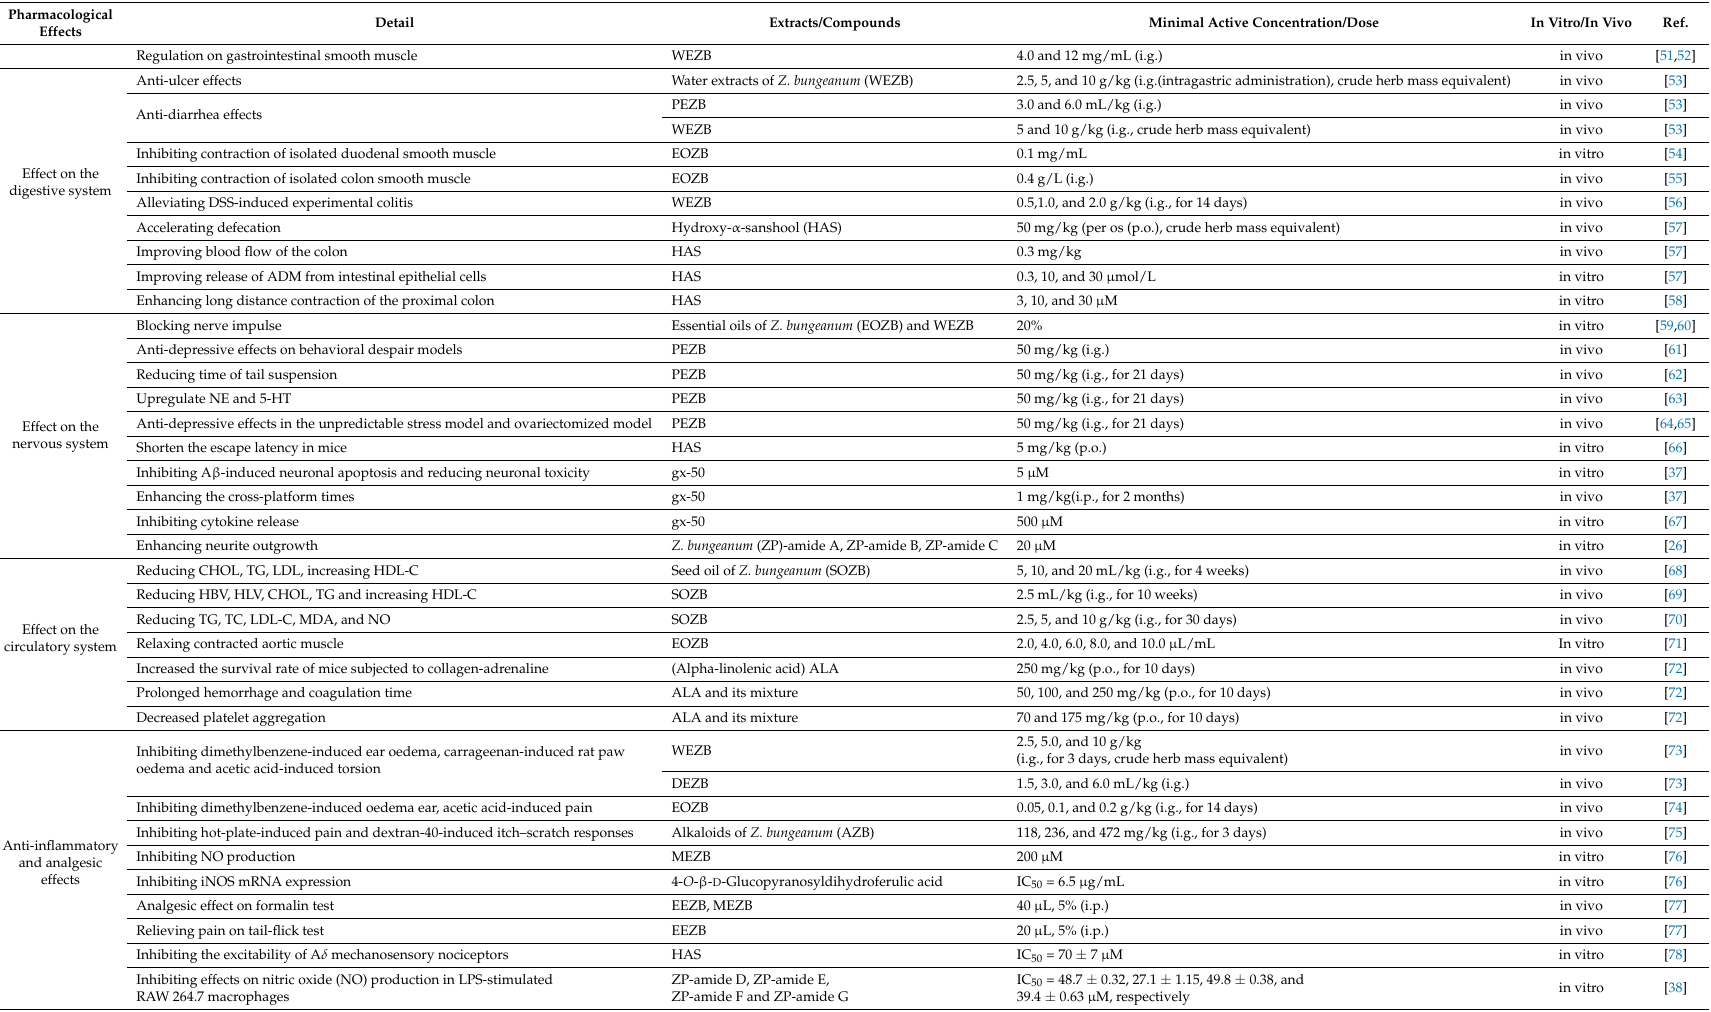
Table 7. Pharmacological effects of Z. bungeanum